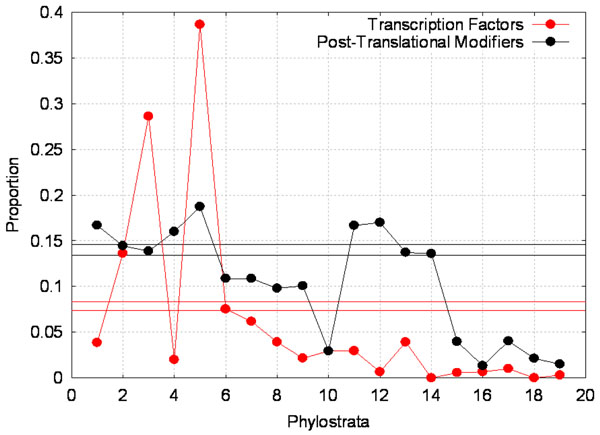
Distribution of transcription factors and proteins that undergo post-translational modification across the phylostrata. Proportion of transcription factors (TF; red profile) and post-translational modifiers (PTM; black profile) originating at each of the 19 phylostrata. Horizontal red and black lines correspond to the bounds of the 95% confidence interval for TF and PTM, respectively, and based on the entire set of 12,753 genes.